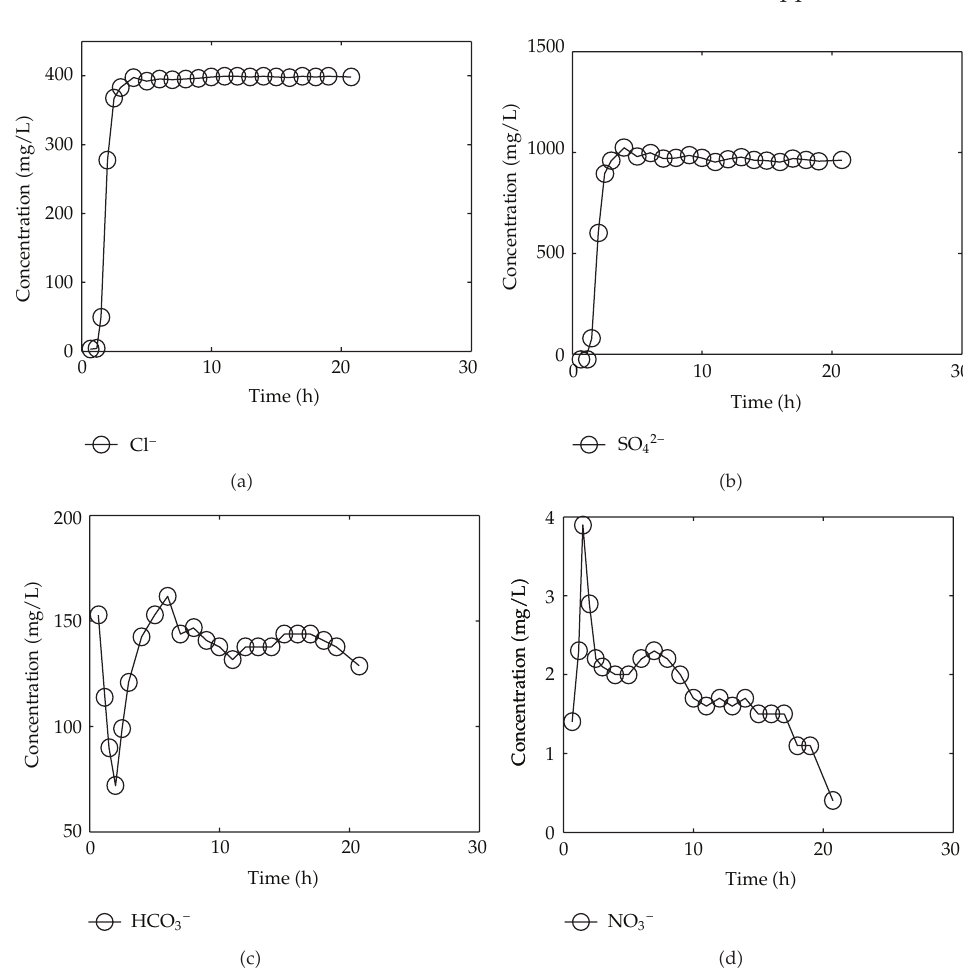
Figure 2: Breakthrough data of negative solute ions in the